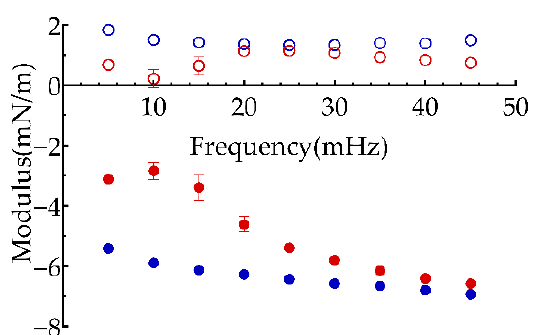
Figure 5. Effect of oscillation frequency on the viscoelasticity of interfacial film formed by polyglycerol-2 dioleate (red) and PGPR (blue). Full and open symbols: dilatational elastic modulus and dilatational viscous modulus.